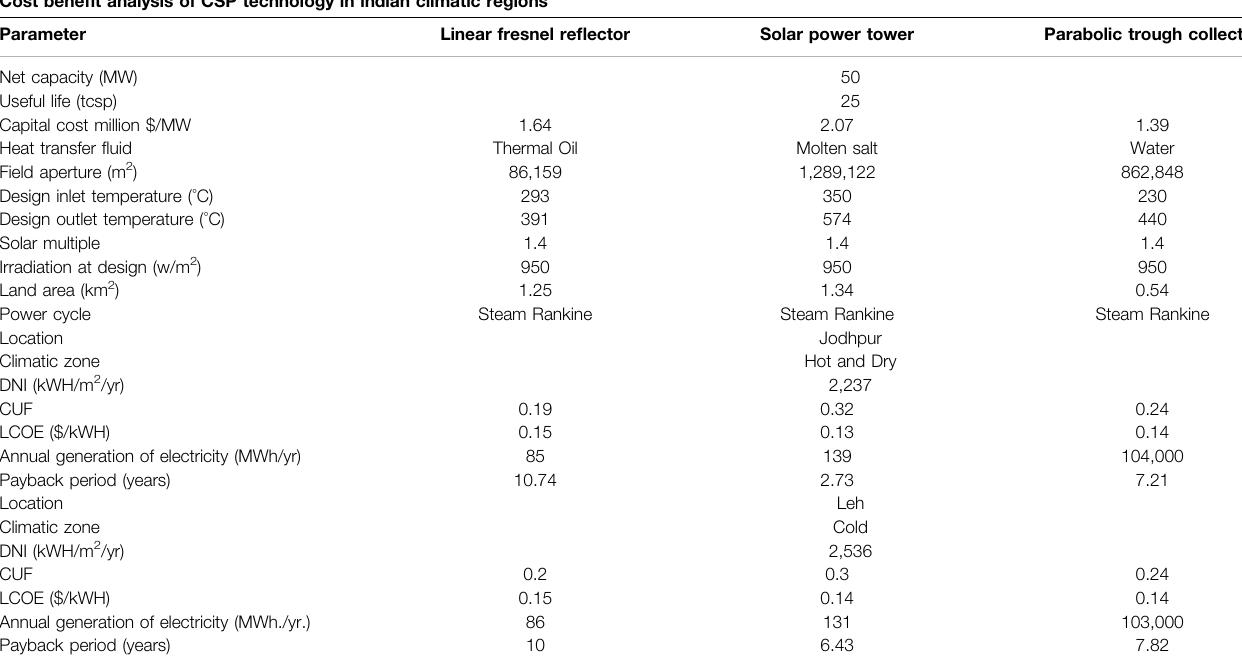
TABLE 2 | Cost-bene fi t analysis of CSP technology in Indian climatic regions (Zineb et al., 2021). Cost bene fi t analysis of CSP technology in indian climatic regions